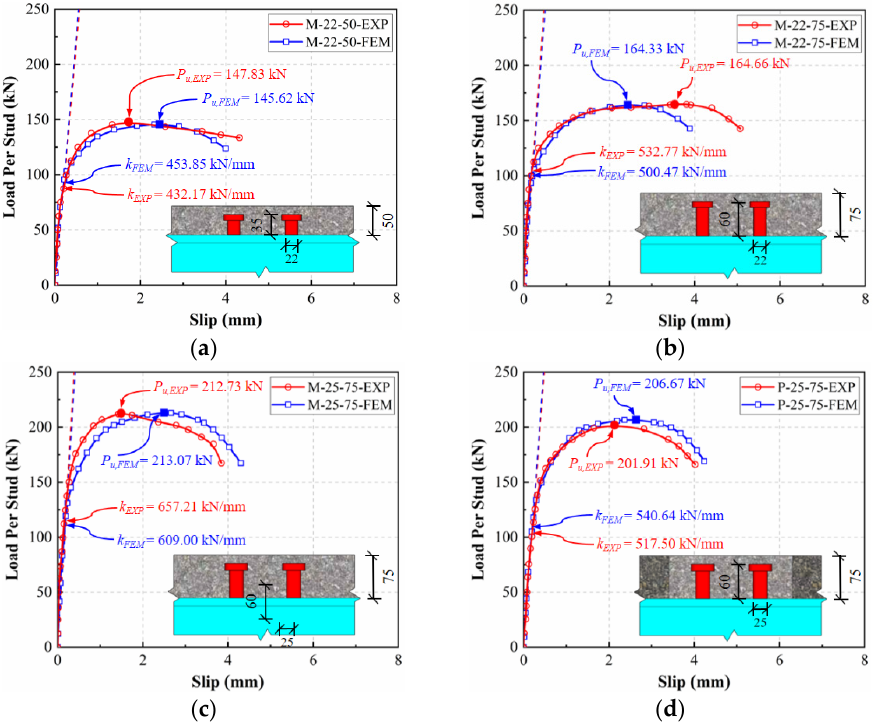
Figure 11. Comparison of load–slip curves from experimental and FE analysis: ( a ) specimen M-22-50; ( b ) specimen M-22-75; ( c ) specimen M-25-75; ( d ) specimen P-25-75. Table 3. Summary of test